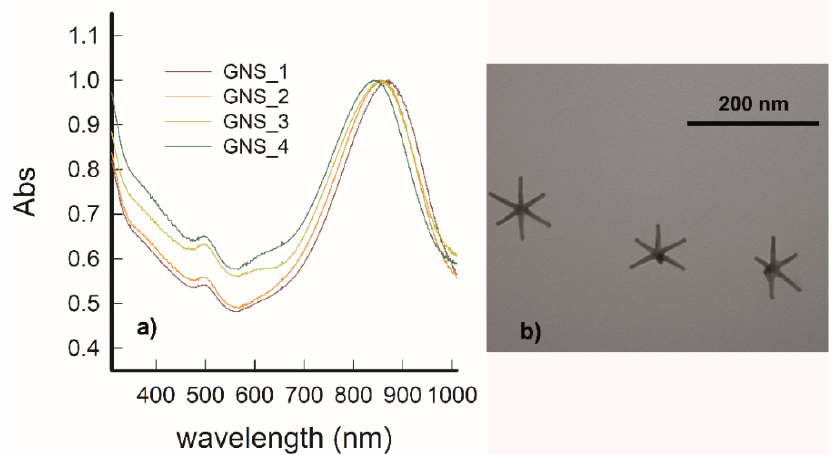
Figure 1. ( a ) LSPR spectra of four colloidal samples of GNS, normalized for intensities, showing the position of LSPR1 and the good reproducibility of the preparation. ( b ) TEM image of GNS from a representative preparation (scale bar, 200 nm).